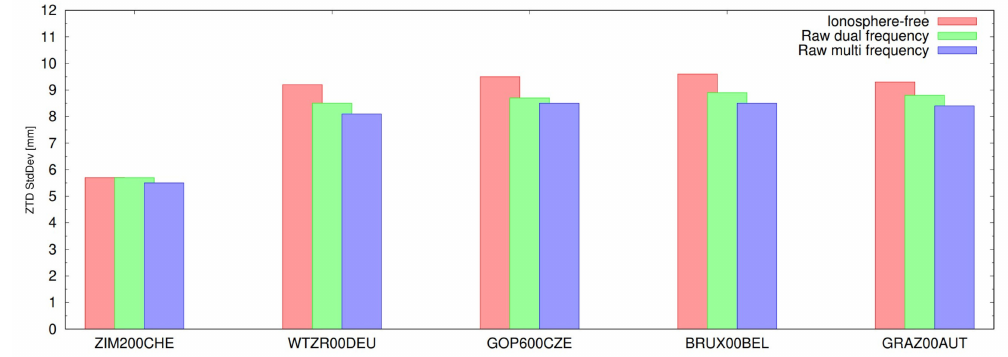
Figure 11. Standard deviation of ZTD estimated with Galileo-only observations and di ff erent processing